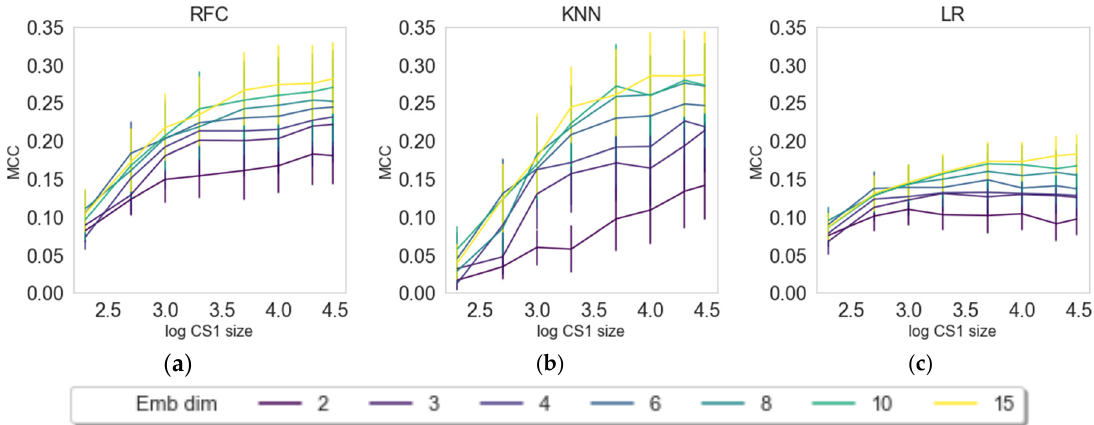
Figure 4. Dependence of classification results or transferred embeddings of CS2 by means of MCC on the log-size of CS1 and dimensions of the VAE embeddings. The three figures represent three classifying algorithms, namely, ( a ) RFC, ( b ) LR, and ( c ) KNN.